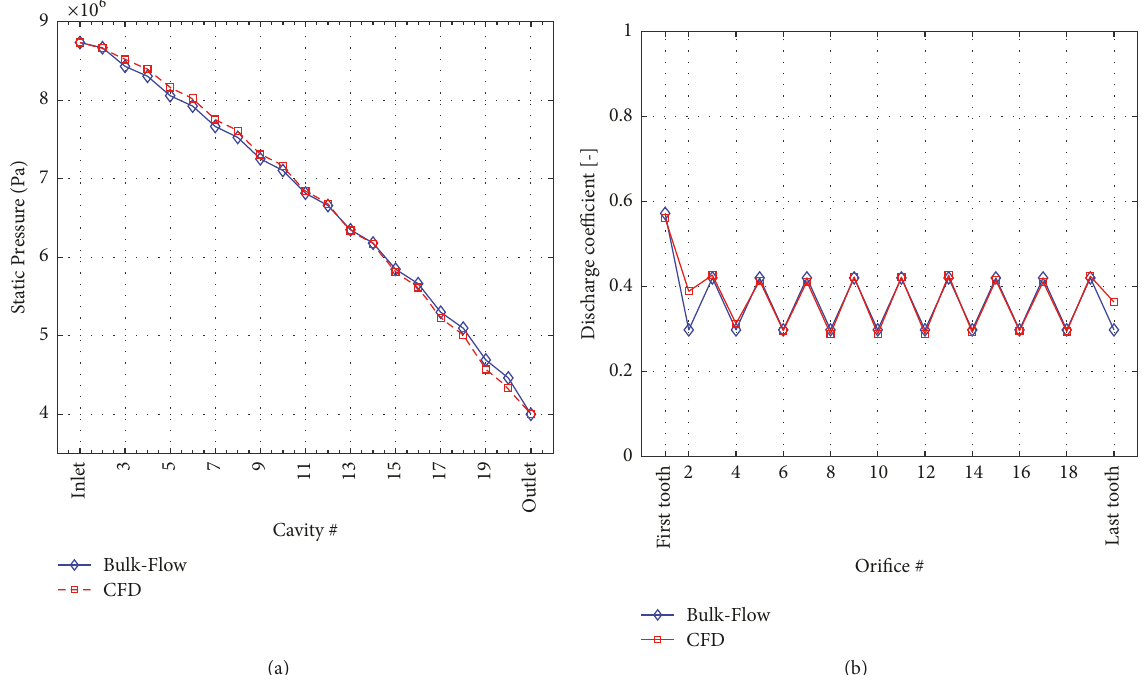
Figure 18: Static pressure distribution in the seal cavities and discharge coefficients in the seal orifices for the test number 1 (seal diameter = 220 mm, pressure drop = 50 bar, inlet preswirl = 1.9, and rotor peripheral velocity = 66.19 m/s).